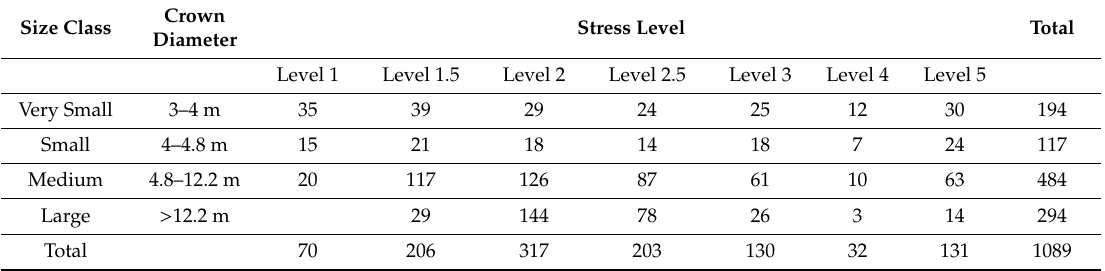
Table 2. Distribution of crown size classes according to their mean diameter per stress symptom level for the refined 7-step reference system with symptom levels from 1 = non-symptomatic to 5 = dead.